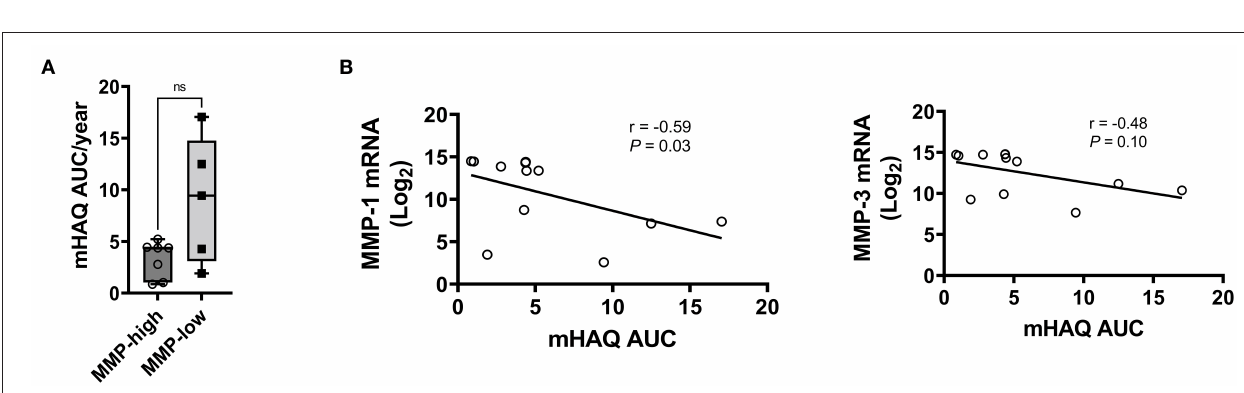
FIGURE 5 | Analysis of long-term clinical outcomes in DMARD-naïve EIA patients— (A) Box-whiskers plot showing mHAQAUC/year after 12.5 years of follow-up between MMP-high and MMP-low groups. Data was analyzed by Mann-Whitney test; ns, non-significant (B) Pearson correlation plots showing the relationship between MMP-1 or MMP-3 levels at baseline and mHAQ AUC scores at 15 year